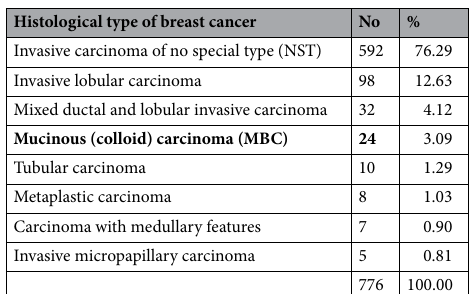
Table 1. Distribution of histological types in the group of 776 patients with invasive breast cancer. Statistically significant results p < 0.05.